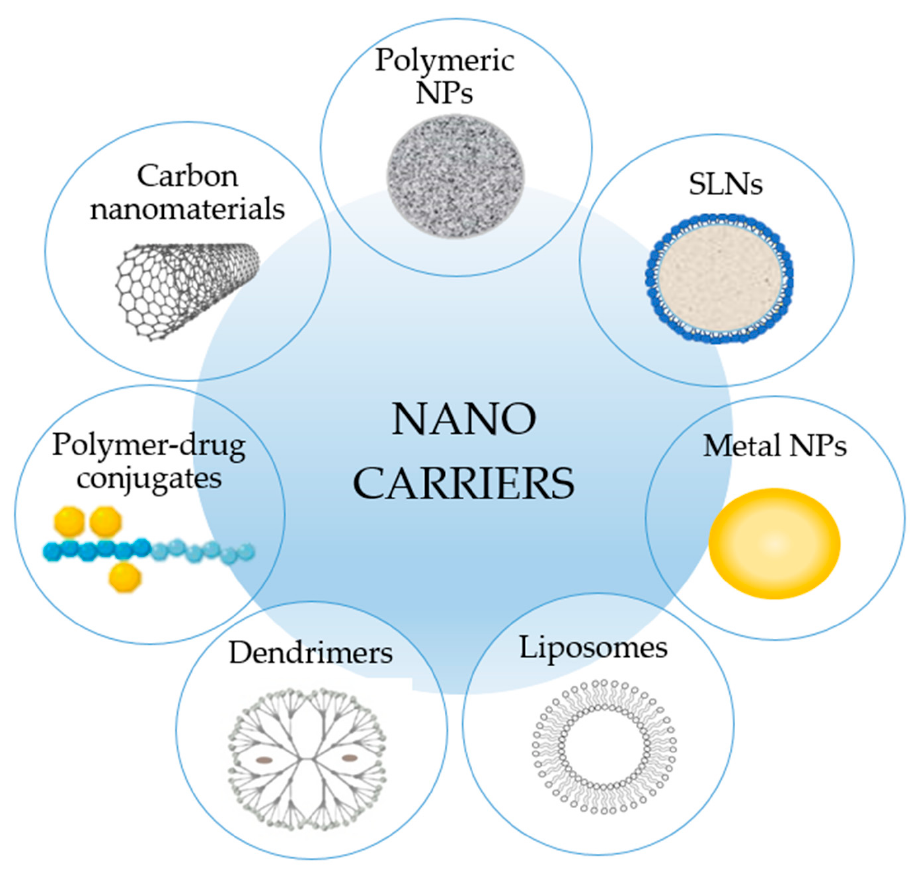
Figure 1. Schematic representation of the most important nanocarriers reported in veterinary